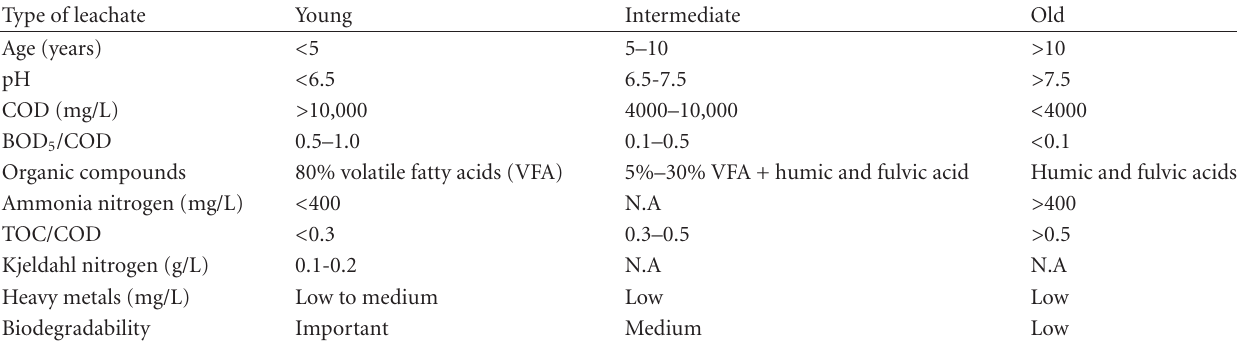
Table 1: Landfill leachate classification versus age [3, 4].